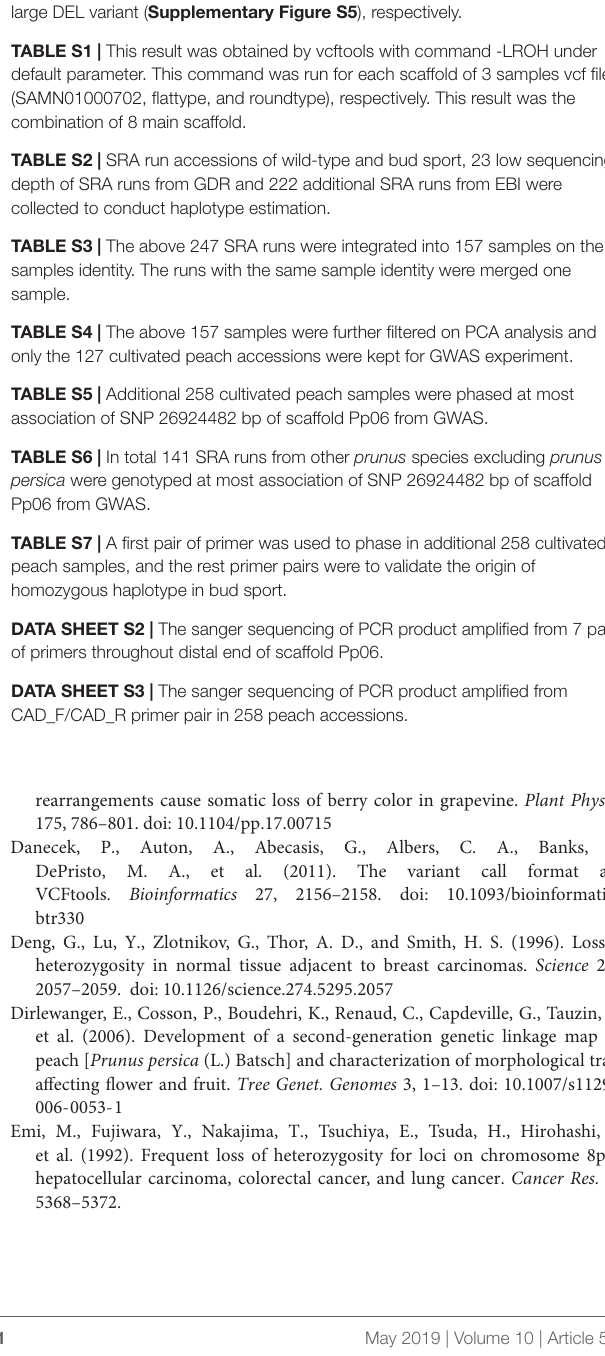
TABLE S1 | This result was obtained by vcftools with command -LROH under default parameter. This command was run for each scaffold of 3 samples vcf file (SAMN01000702, flattype, and roundtype), respectively. This result was the combination of 8 main scaffold. TABLE S2 | SRA run accessions of wild-type and bud sport, 23 low sequencing depth of SRA runs from GDR and 222 additional SRA runs from EBI were collected to conduct haplotype estimation.